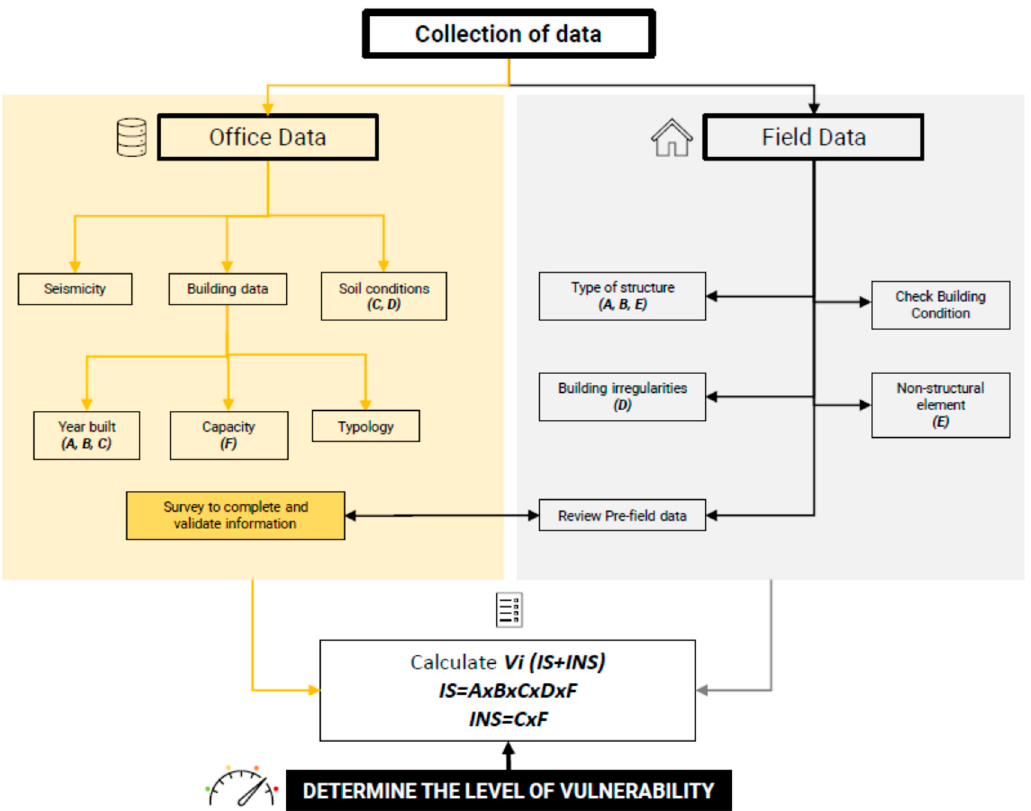
Figure A1. Flowchart of the RVs procedure used to analyze the vulnerability of accommodation buildings.